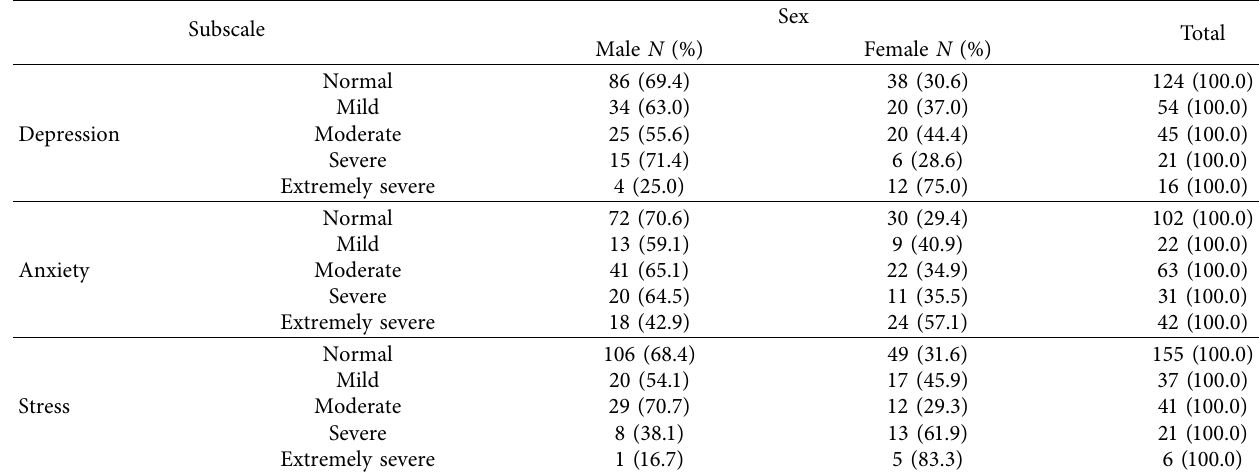
Table 3: Severity distribution of depression, anxiety, and stress in relation to gender, N � 260, AU, January 2019.